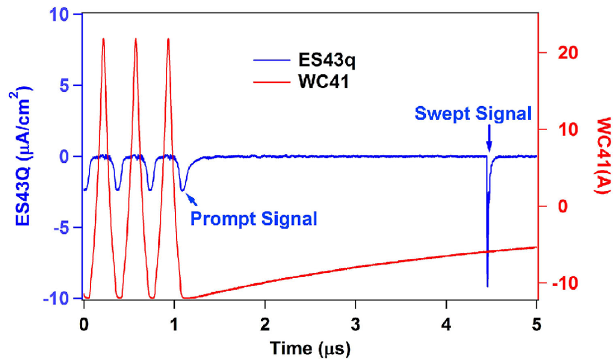
FIG. 7. (Color) Histogram of simulation results for the azimu- thal angular distribution of electrons striking the wall in a quadrupole magnet. The vertical red lines show the 18 degree angular region (27 to 45 degrees) for the entrance holes of the